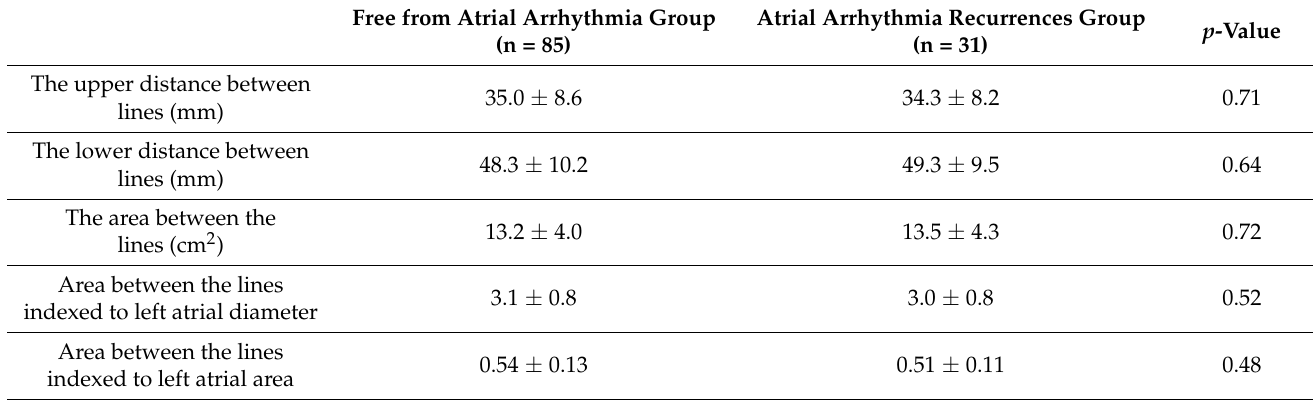
Table 3. Analysis of the impact of the distance between lines on arrhythmia recurrence